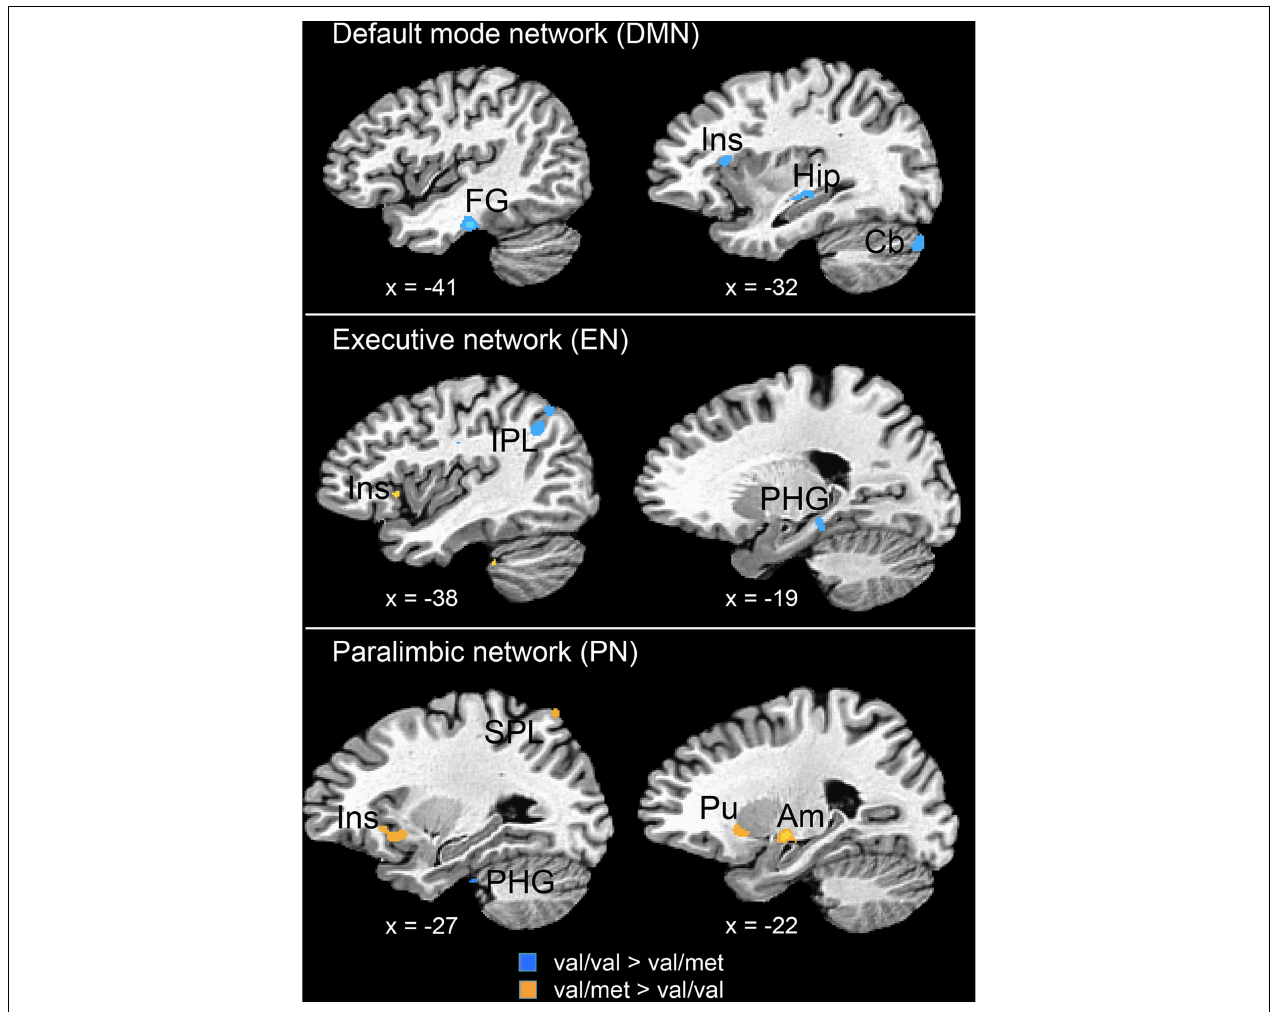
FIGURE 3 | Two-sample t -tests for three major resting-state networks. BDNF gene group differences (val/val > val/met: blue; val/met > val/val: orange) across three resting networks. FG = fusiform gyrus, Ins = insula, Hip = hippocampus, IPL = inferior parietal lobule, PHG = parahippocampal gyrus, SPL = superiorparietal lobe, Pu = putamen, Am = amygdala; p <